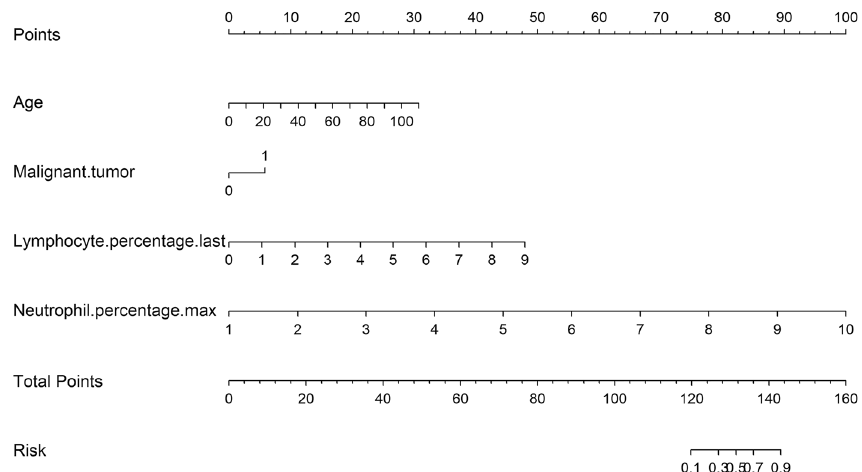
Figure 4. Nomogram curve.